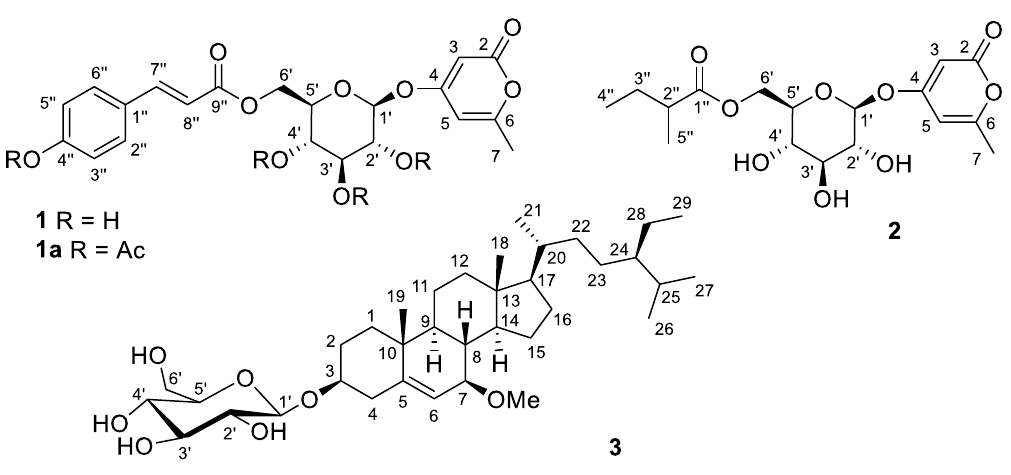
Fig. 1 Chemical structures of new compounds ( 1 – 3 ) and the acetylated derivative of